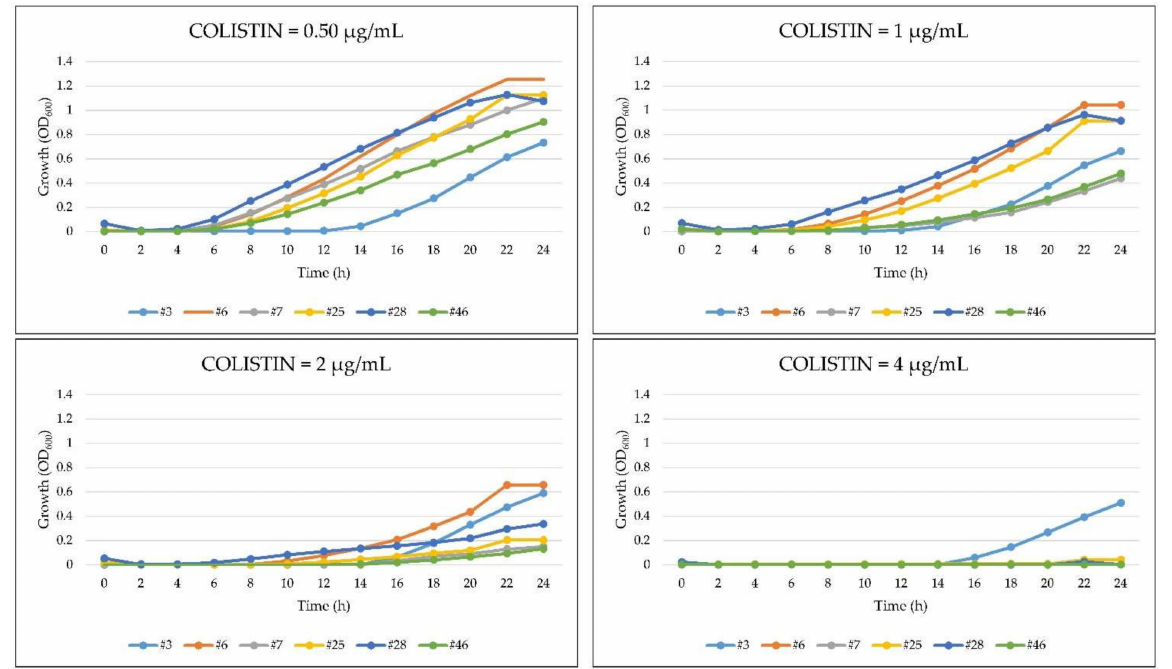
Figure 3. Growth profiles of six A. baumannii strains characterized by discordant MIC values for colistin (colistin-sensitive in the Vitek ® 2 assay but resistant in the broth microdilution